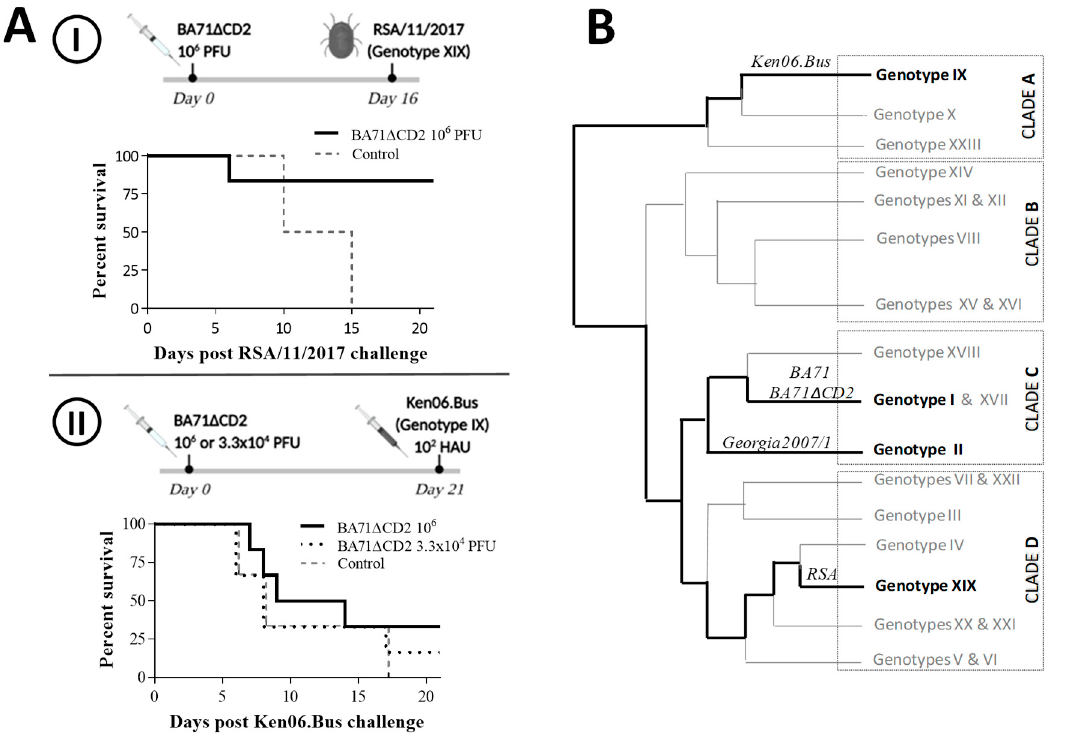
Figure 1. ( A ) Schematic representation of two in vivo experimental designs with the survival rates observed after African swine fever virus (ASFV) challenge and ( B ) ASFV phylogenetic tree showing the genetic distance between different ASFV genotypes and clades described so far, based on Muangkram et al., 2015 [14]. In Italic, strains used in this study: BA71 (genotype I); Georgia2007/1 (genotype II); RSA/11/2017 (genotype XIX); and Ken06.Bus (genotype IX).